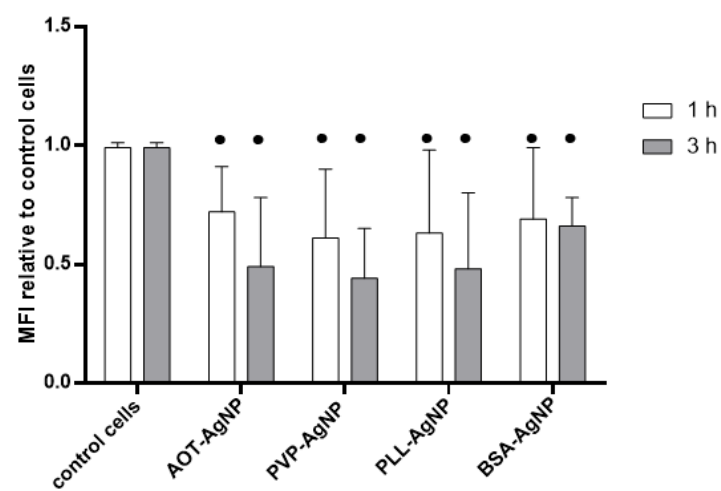
Figure 7. Effect of different AgNPs on mitochondrial membrane potential of hPBMC determined by DiOC 6 staining after 1 (white columns) and 3 h (grey columns) of exposure. Data are given as ratio of geometrical MFI of treated relative to control, nontreated cells. All results are presented as the mean of 6 experiments including SD represented as error bars. Significant differences between treatments and control cells are denoted by dots (●) ( p < 0.05).